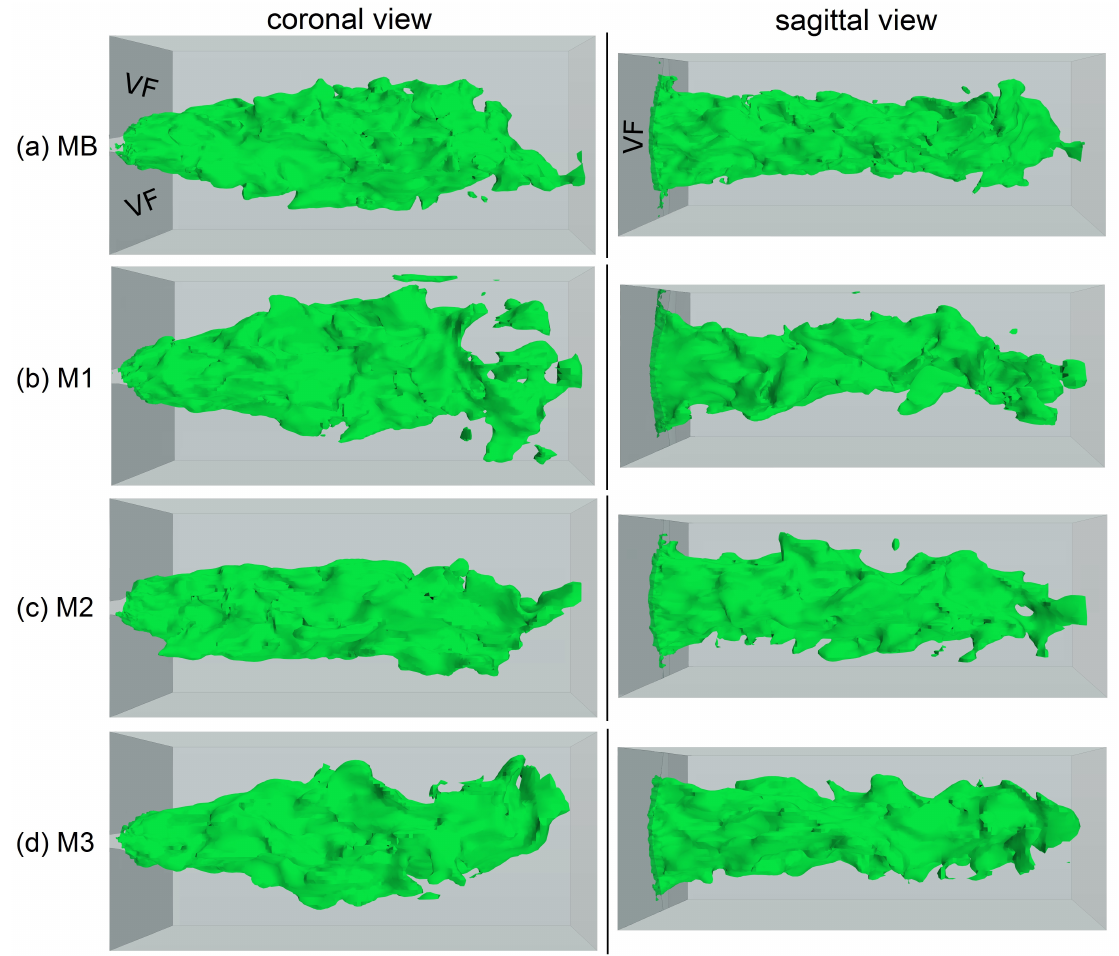
Figure 10. Velocity magnitude iso-surface of 50 m/s at the time instance 0.58 T in the oscillation cycle in coronal (left column) and sagittal (right column) perspectives for meshes MB–M3 (parts ( a – d )). The flow rates during an oscillation cycle are shown in Figure 11 for all four mesh